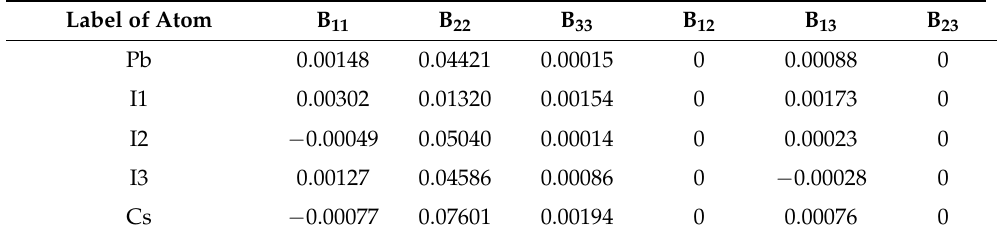
Table 2. Anisotropic thermal factors for the same